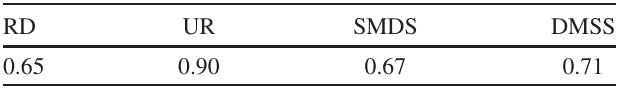
TABLE II. Human-to-human comparison of Cohen ’ s kappa for IRR on a sampling of data from each of the four probes of the PMQ, where RD stands for “ repeating distance, ” UR stands for “ using repeats, ” SMDS stands for “ same mean different spread, ” and DMSS stands for “ different mean same spread ” .